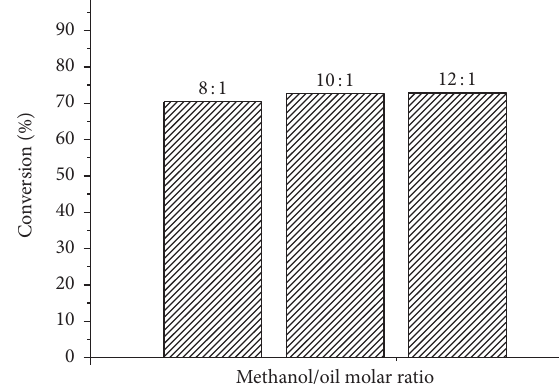
Figure 10: The influence of methanol to oil ratio on esterification